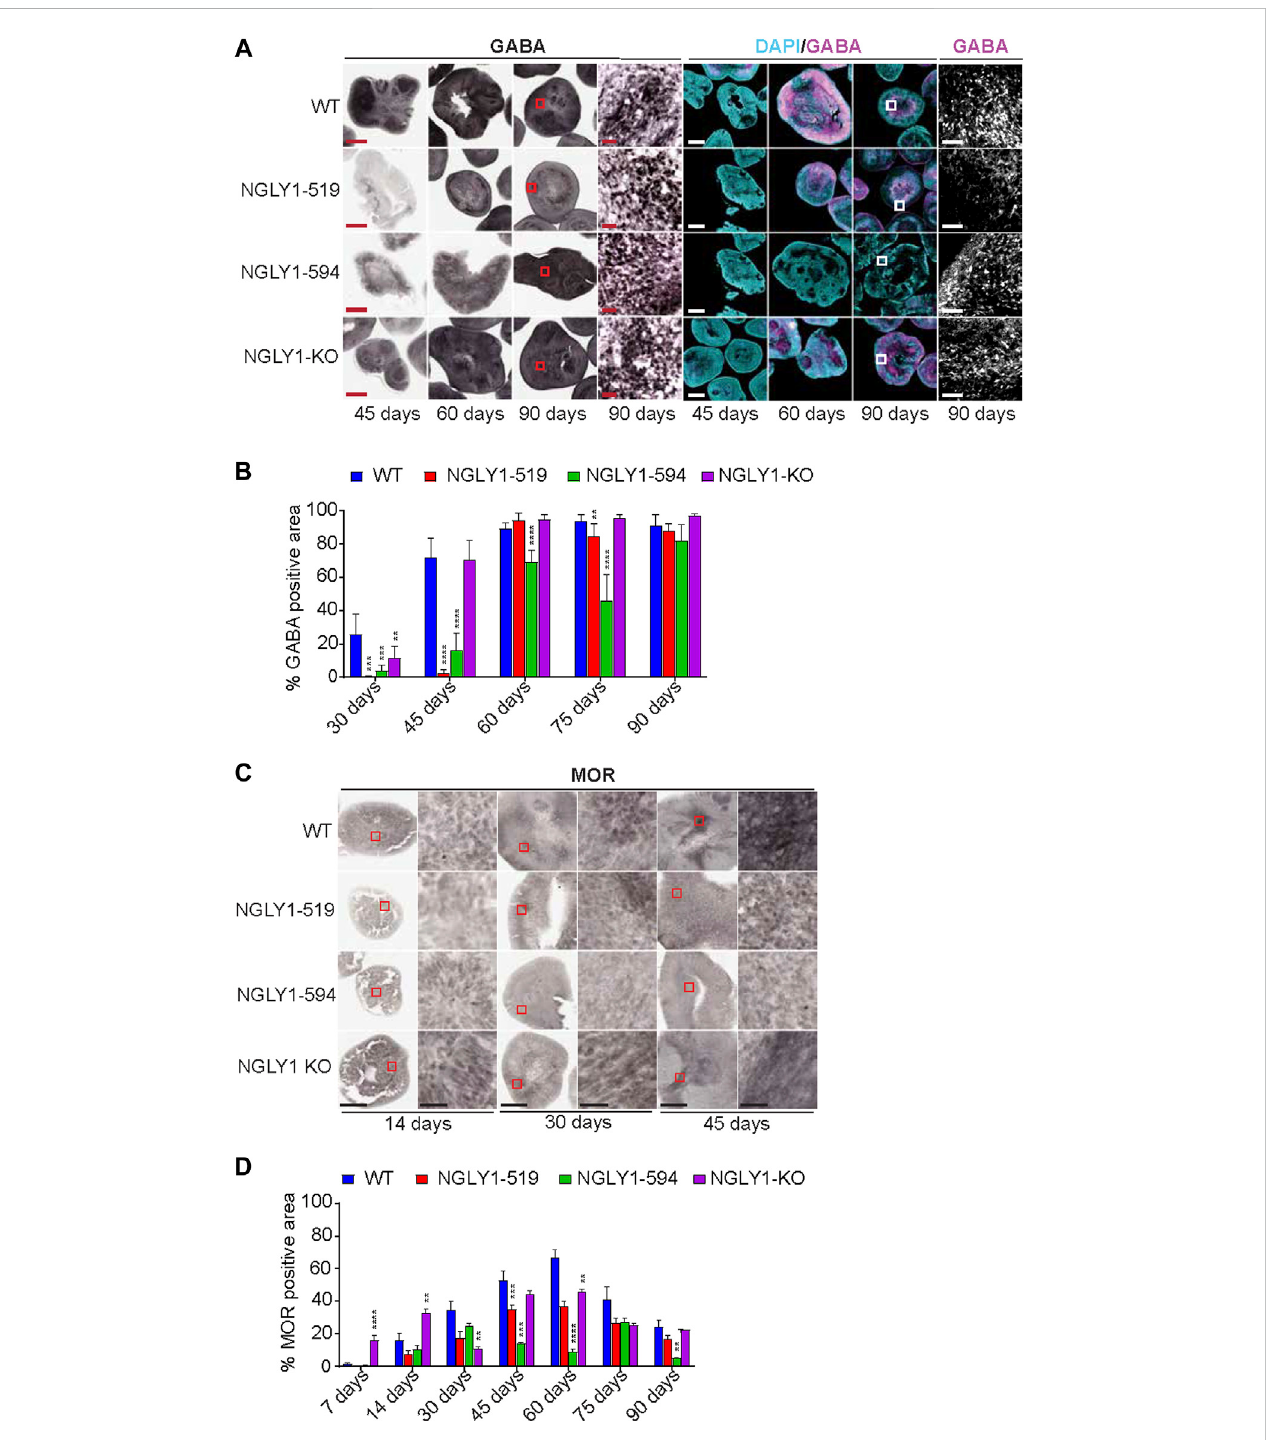
FIGURE 5 Expression of GABA and MOR in NGLY1 midbrains. (A) Representative images using bright fi eld and immuno fl uorescence microscopy for WT, NGLY1diseasedandNGLY1KOmidbrainorganoidsstainedwithantibodyagainstGABAatdifferenttimepoints(45,60and90days).Scalebars:500 µM(for45, 60and90days)and50 µM(for90days zoomedinimage). (B) GraphshowingpercenttotalGABApositive signalindifferentorganoidsatdifferenttimepoints. (C) Representative bright fi eld immunohistochemistry images for MOR expression at ×4 and ×40 magni fi cation. Scale bars: 250um (4x) and 25um (40x), red boxes indicate zoomed in region. (D) Quanti fi cation of total percent positive MOR staining. Data representative of all slices derived from three midbrain organoids. Statistical signi fi cance determined by multiple t -test analysis denoted by * = ( p ≤ 0.05), ** = ( p ≤ 0.01), *** = ( p ≤ 0.001), **** = ( p ≤